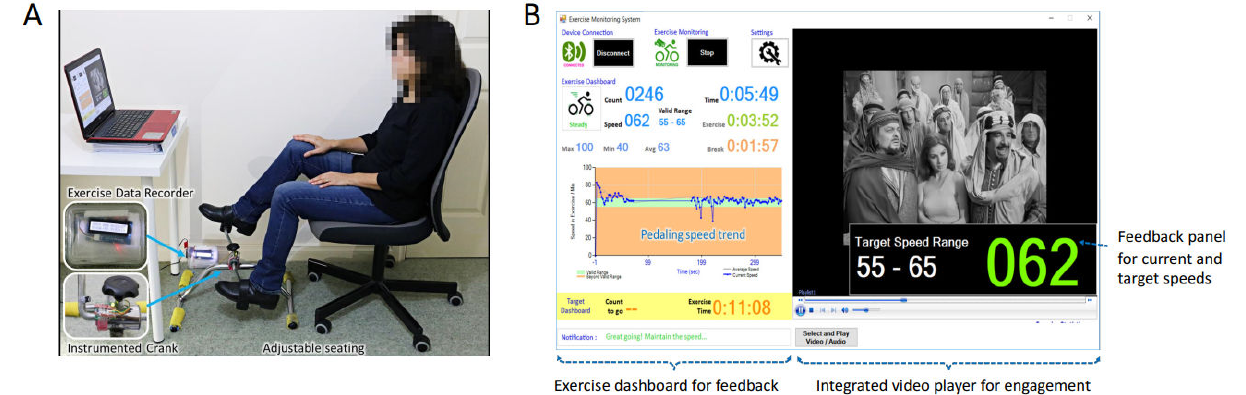
Figure 1. Experimental setup of a custom-designed apparatus used for pedalling trials ( A ) and software graphic user interface (GUI) on a PC used for feedback and engagement ( B ). The pedalling apparatus comprised an adjustable computer seat, a pair of pedals, a crank instrumented with a cadence sensor, a data recorder to measure pedalling cadence, and a customised software suite running from the computer. The software GUI displayed exercise performance feedback on a dashboard, while an integrated video/music player was also displayed to provide engagement during exercise.